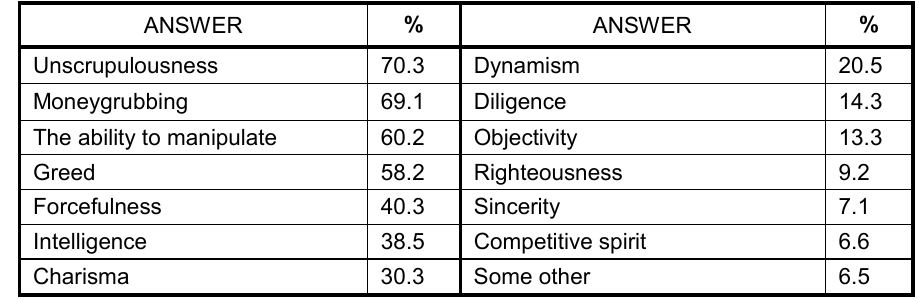
Table 1 – Which of the following characteristics usually characterize Serbian leaders? (Ajdukovi ć , 2007) Таблица 1 – Какие наиболее распространенные черты сербских лидеров ? (Ajdukovi ć ,